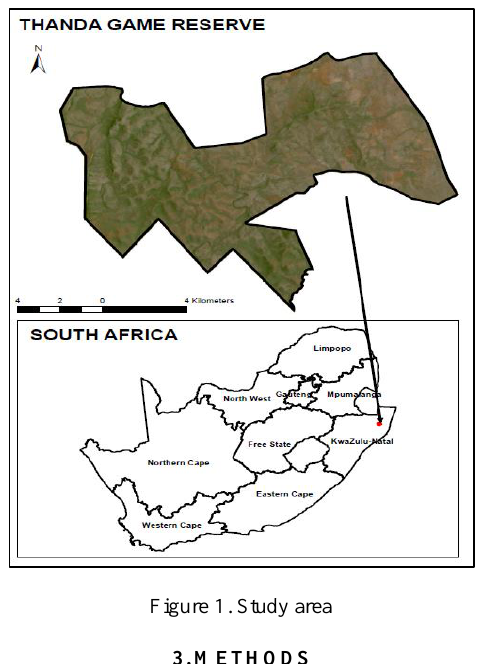
Figure 1. Study area